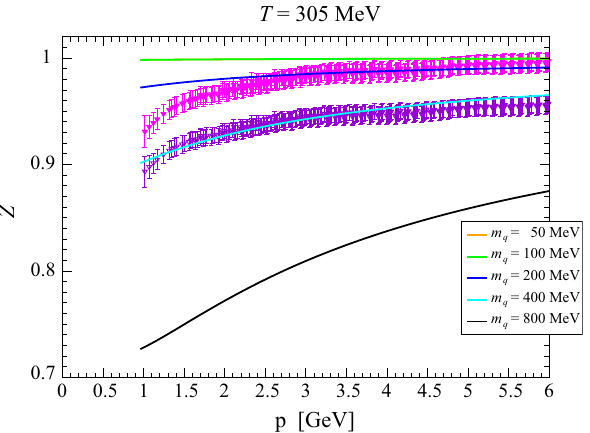
Fig. 7 The lattice and HTL quark wave function at T = 305 MeV. The lattice data was rescaled to reproduce the HTL wave function at 3 GeV for m q = 200 MeV (full symbols) and for m q = 400 MeV (open symbols). Note that the data for m q = 50 MeV and 100 MeV are indistinguishable in the plot